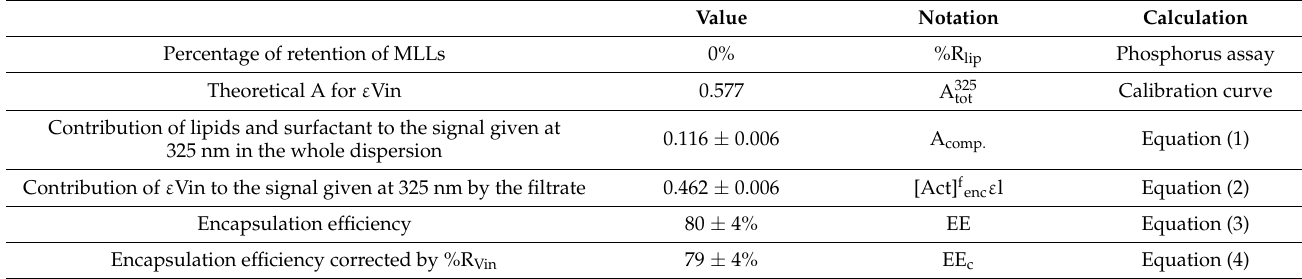
Table 2. Data values to calculate the encapsulation efficiency of ε Vin in